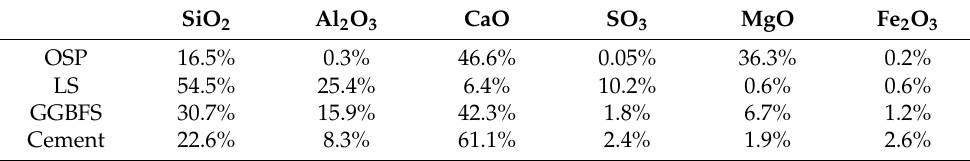
Table 1. Chemical composition and content of materials (mass fraction/%).